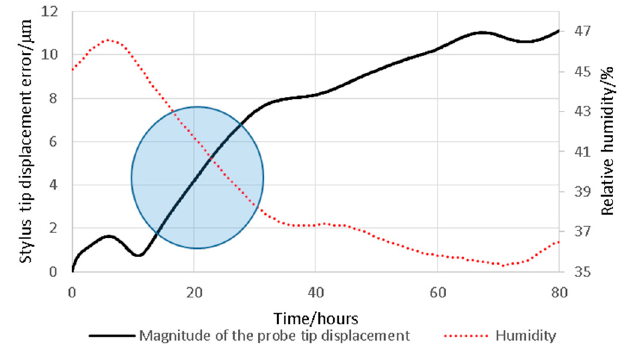
Figure 8. A plot of the magnitude of the stylus tip drift and relative humidity within the isolation enclosure over an eighty hour period. The steepest gradient area is indicated with an overlayed circle; in this region the rate of change of stylus tip position reaches a maximum of 6 nm per minute.